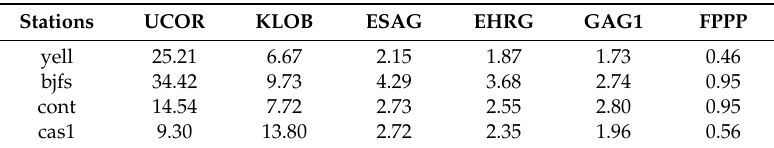
Table 6. The RMS of individual station for Case 1 (TECU).